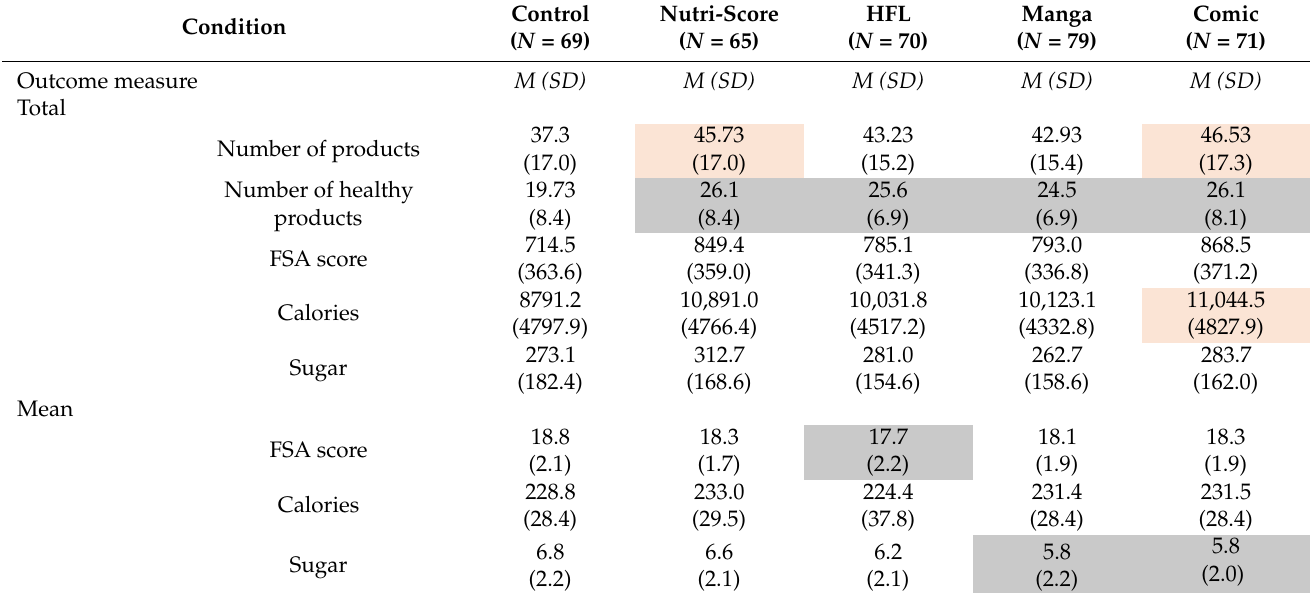
Table 1. Total and mean scores of the chosen outcome measures (or operationalizations) per